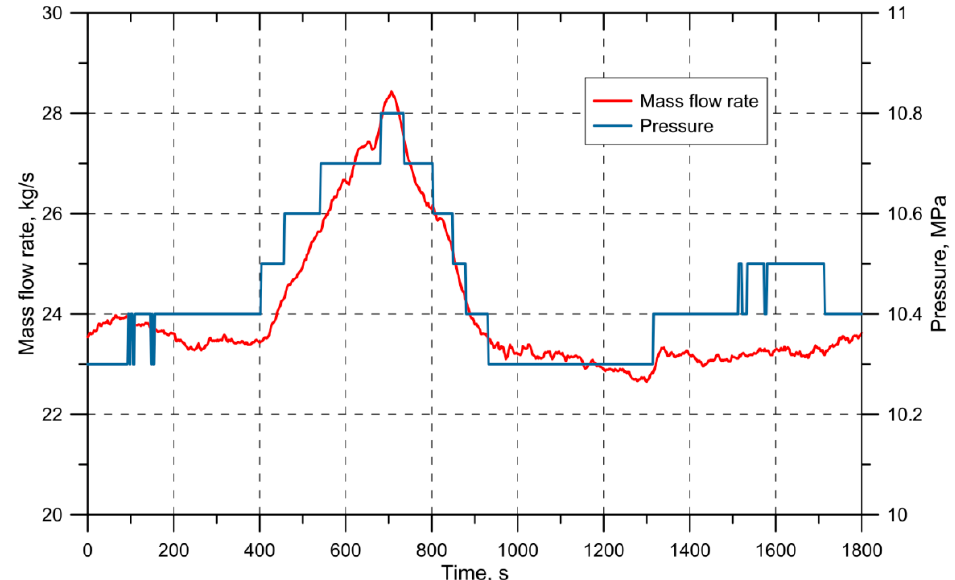
Figure 15. Steam pressure, and mass flow rate of steam as functions of time.